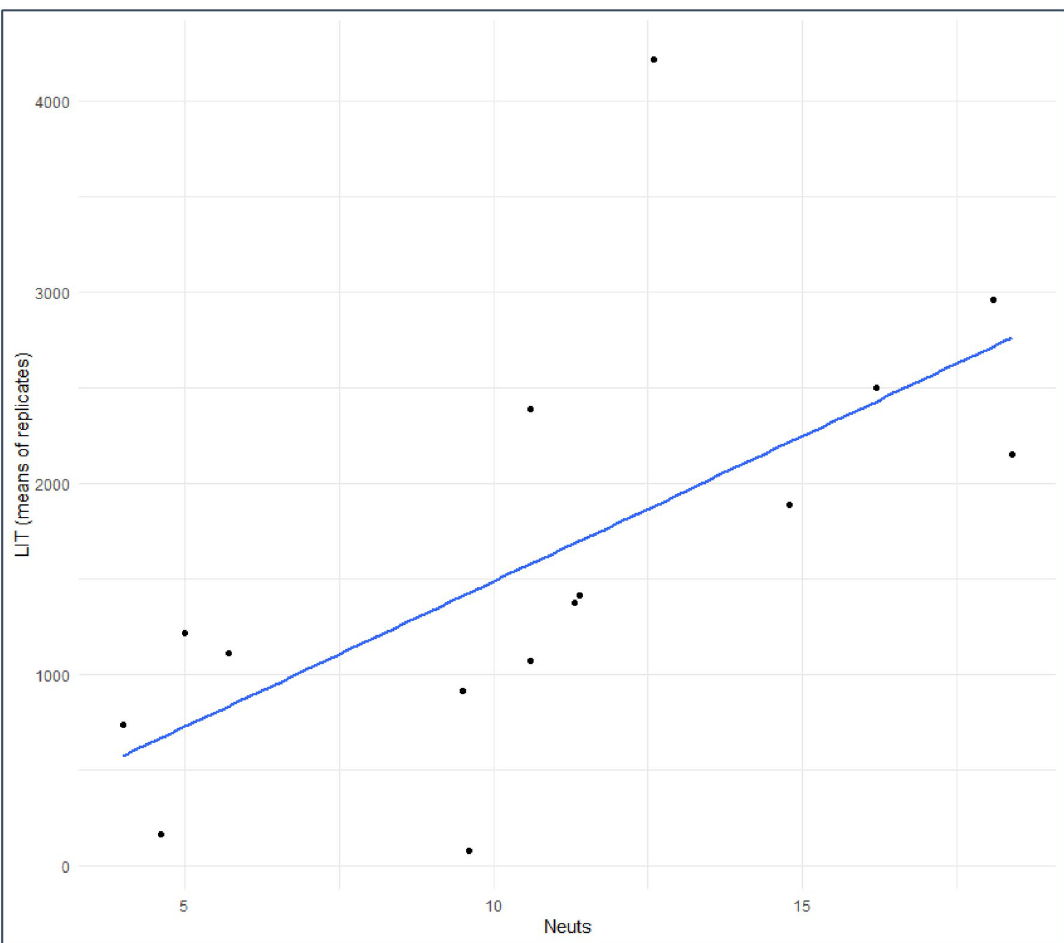
Figure 3. Scatterplot to show correlation between LIT and neutrophil count in patients with COVID-19. LIT scores and neutrophil counts are positively correlated (Spearman’s rho = 0.80 [0.52, 0.92] (p =